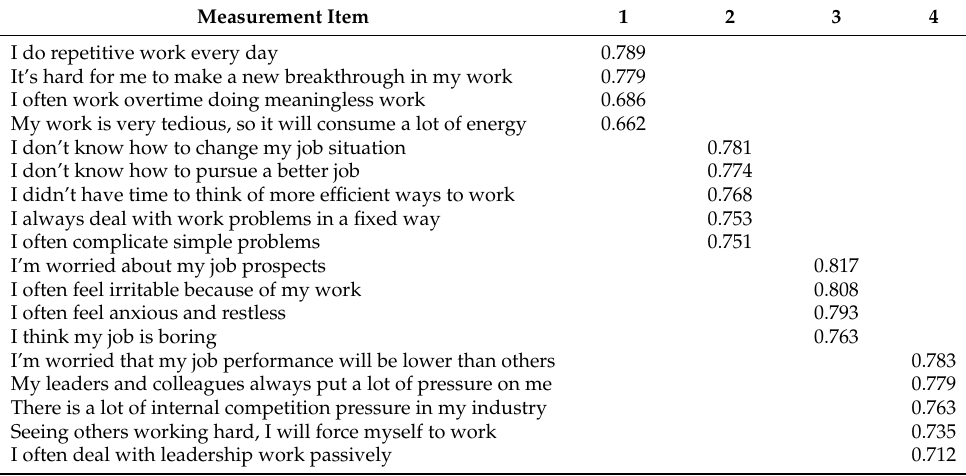
Table 7. Exploratory factor analysis results of employee involution